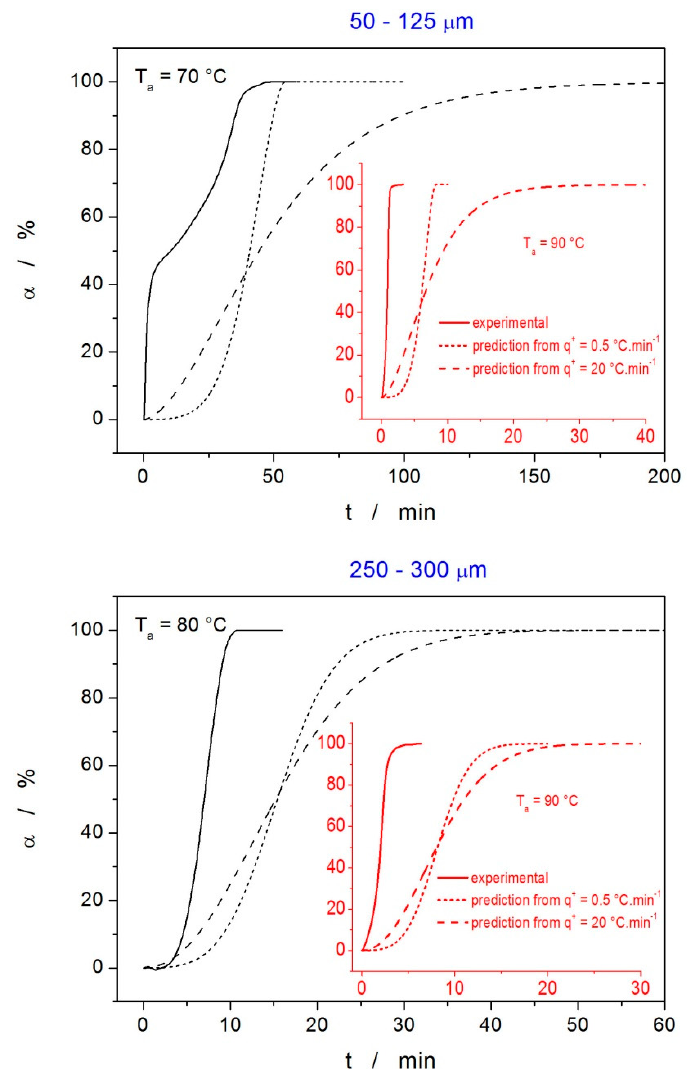
Figure 10. Tests of the kinetic prediction accuracy for isothermal crystallization based on the de- scription of nonisothermal DSC data—the kinetic parameters of this description are listed in Table 1. For each of the two tested powders (50–125 µm and 250–300 µm), two annealing temperatures were selected and the corresponding isothermal crystallization experiments performed—solid lines represent the α –t data. For each of these four isothermal experiments, two theoretical predictions were made using the kinetic parameters obtained from the nonisothermal crystallization data meas- ured at 0.5 and 20 °C·min − 1 .